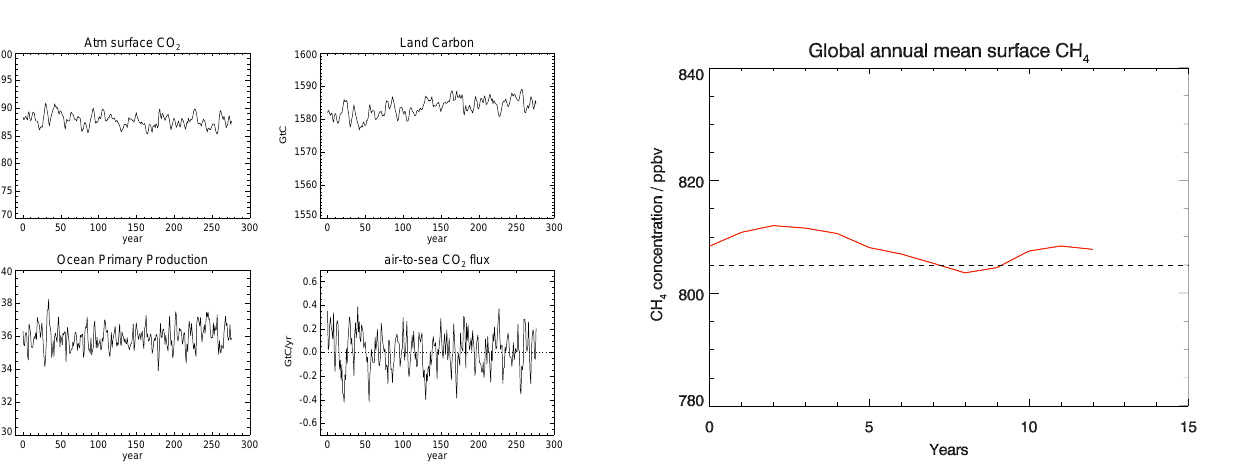
Fig. 4. Atmospheric CO 2 , land carbon store, ocean primary pro- ductivity and the air to sea CO 2 flux from 280yr of the HadGEM2 control integration under 1860 conditions.